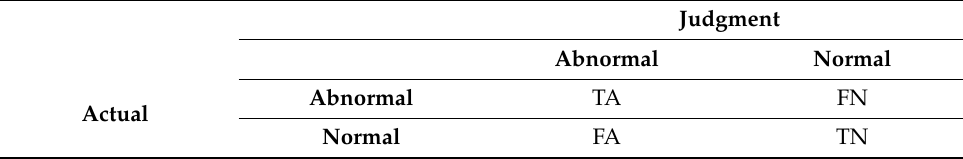
Table 2. Confusion matrix for abnormal